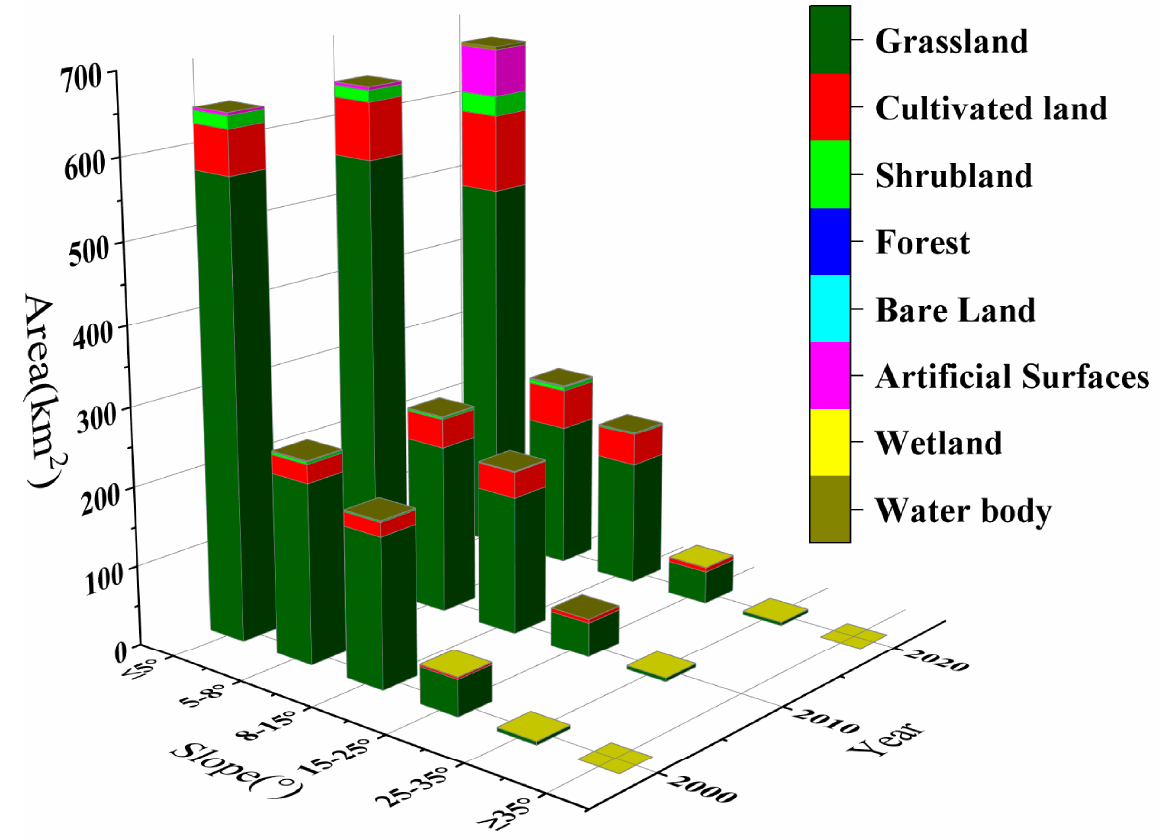
Figure 6. Area of land use/cover of alluvial fans at different slope grades. Compared with 2000, the grassland areas of all slope gradients showed downward trends, but the area of ≤ 8 ◦ decreased the most. The decreased areas in 2010 and 2020 accounted for 65.52% and 79.58% of the total decreased area of grassland, respectively. The higher the slope was, the smaller the decrease in grassland was. For example, in 2000, the slope-gradient area of 8 ◦ –15 ◦ accounted for 18.12% of the total grassland area. In 2010 and 2020, its decreased area accounted for 30.02% and 17.86% of the total decreased area of grassland, respectively. The decrement trend of forestland area was similar to that of